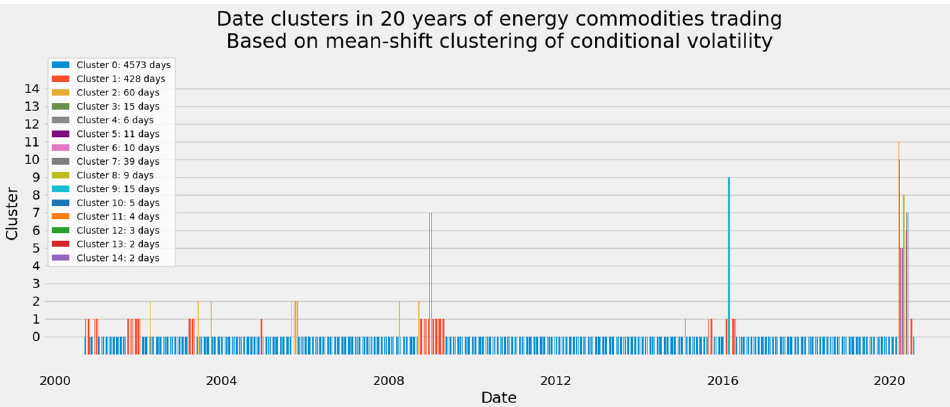
Figure 21. Mean-shift clustering of energy-related markets—An ordered timeline.